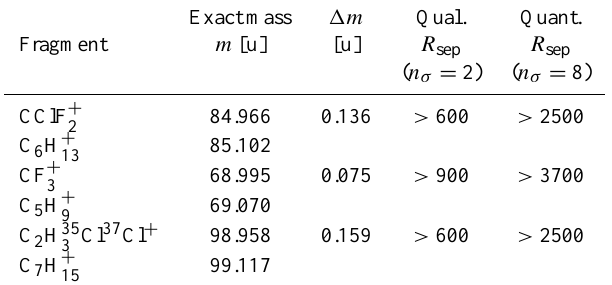
Table 4. The difference of the minimal (Min) and maximal (Max) values in % in one reproducibility experiment for the relative re- sponse is shown with a 1 σ relative standard deviation (RSD) over all measurements (20) on this day. In the comment line the trend of the calibration gas over the day is